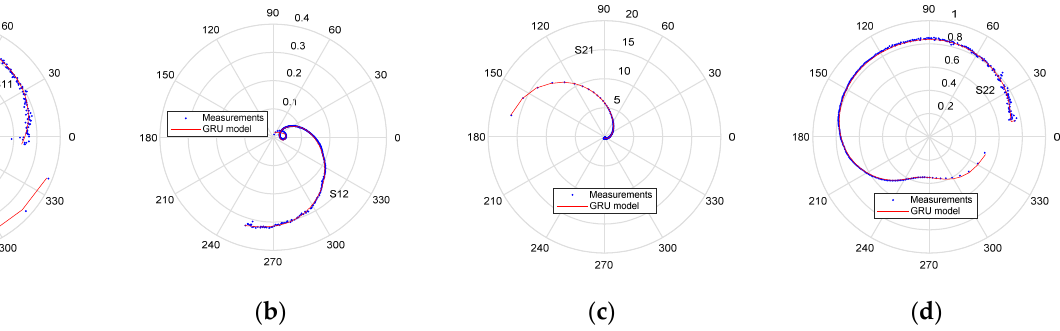
Figure 16. Measured (blue symbols) and GRU simulated (red lines) behavior of ( a ) S 11 , ( b ) S 12 , ( c ) S 21 , and ( d ) S 22 with the frequency range spanning from 200 MHz to 65 GHz for the DUT at V DS = 30 V, V GS = − 3.1 V, and T a = 145 °C.